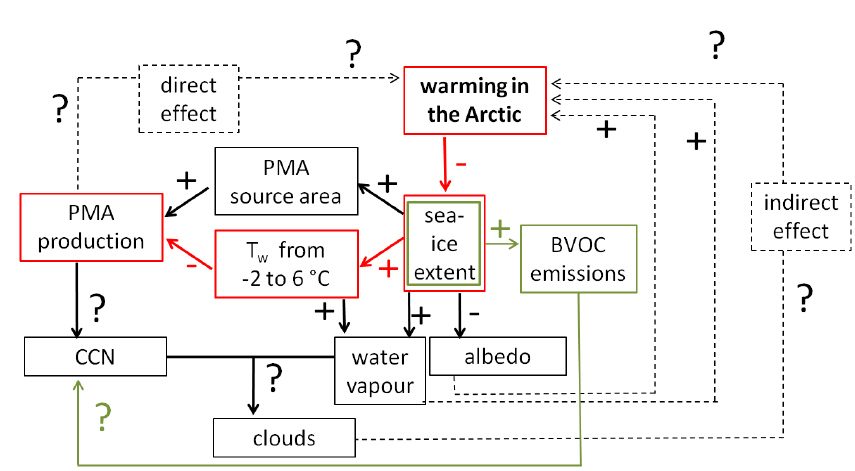
Fig. 12. Potential feedback loop resulting from a warming in the Arctic. Plus signs indicate increases, and minus signs indicate decreases. Question marks indicate that the direction of the change is not clear. The focus of this study is marked by the red colour. The green colour indicates the path related to changes in BVOC